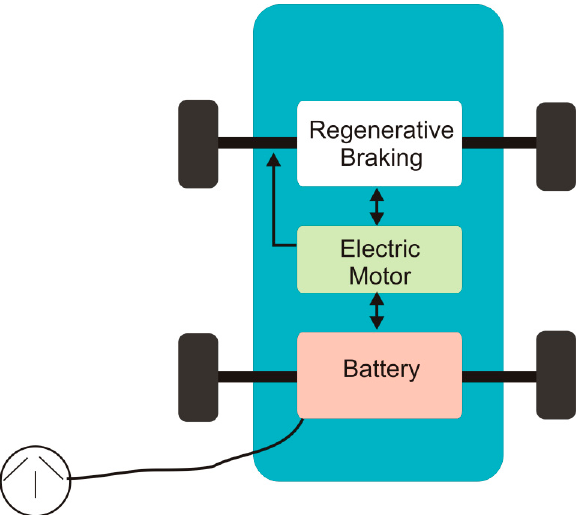
Figure 3. Architectural diagram of battery electric vehicles (BEV).